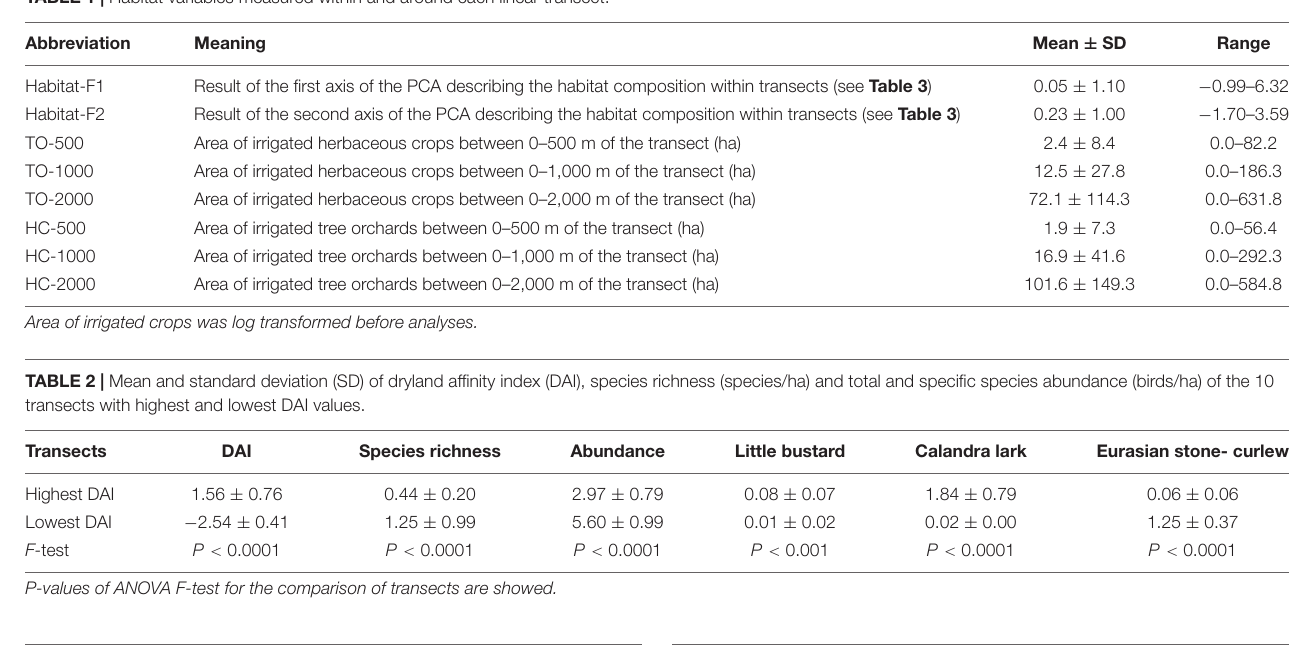
TABLE 4 | Results of the multi-model inference analyses and model averaging for the effects of local habitat within transects (Habitat-F1 and F2) and